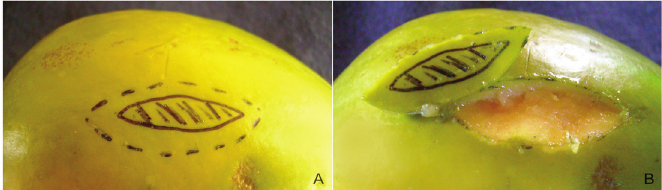
FIGURE 3 – Organic model for the training of basic surgical techniques.